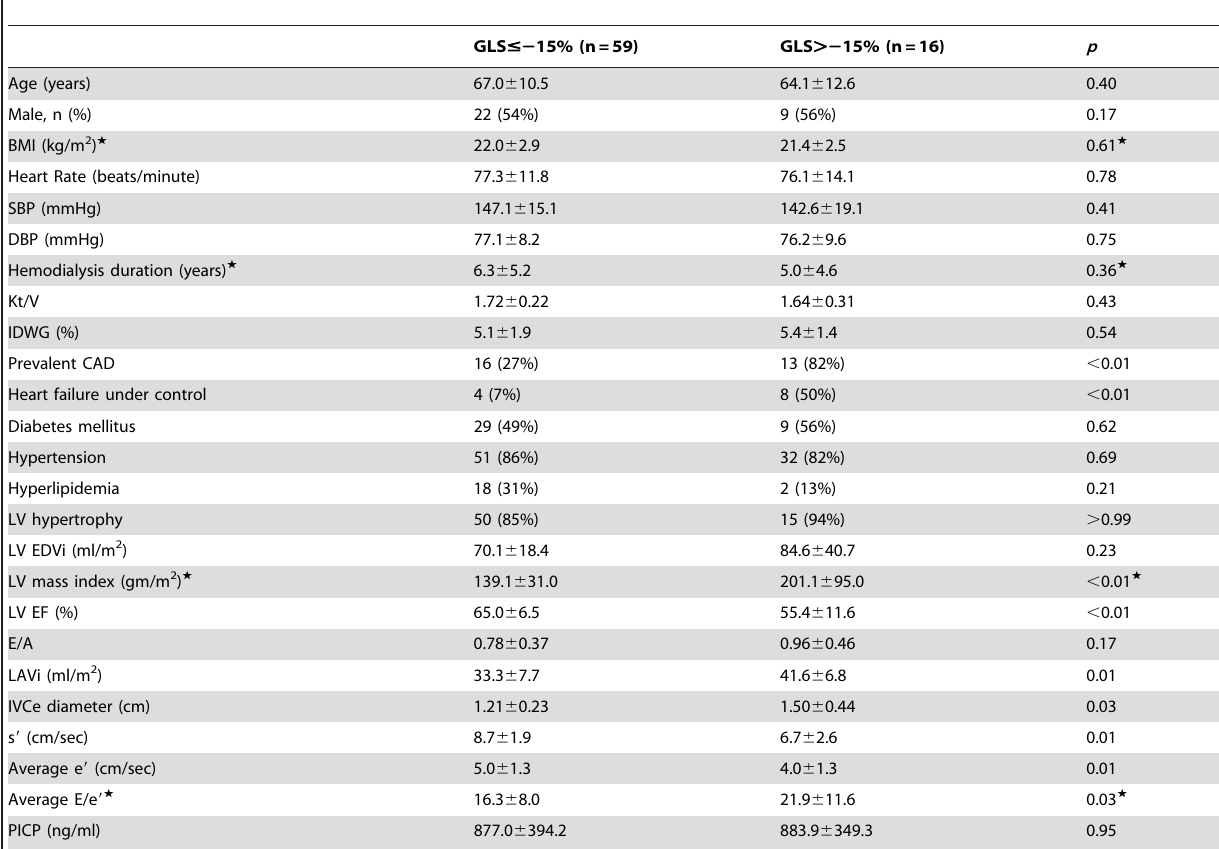
Table 3. Baseline demographic characteristic of hemodialysis patients with left ventricular global peak systolic longitudinal strain (GLS) #2 15% or GLS .2 15%.